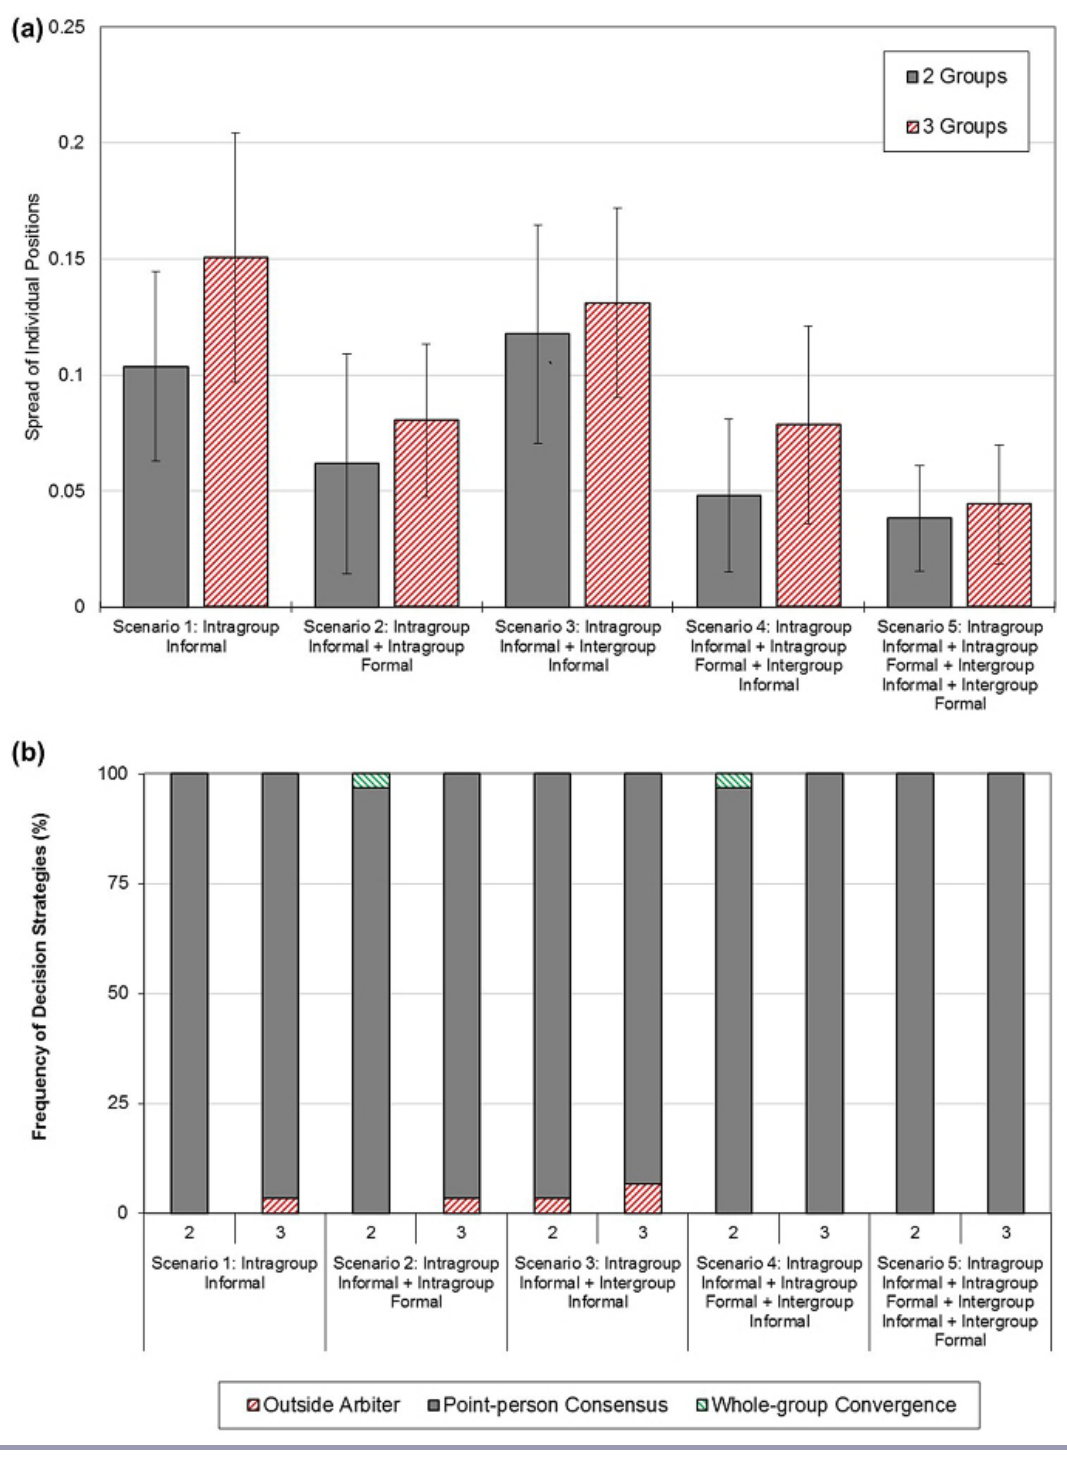
Fig. 5 . Effect of interaction types on: (a) the spread of individual positions, and (b) frequency of decision strategies. Error bars are + 1